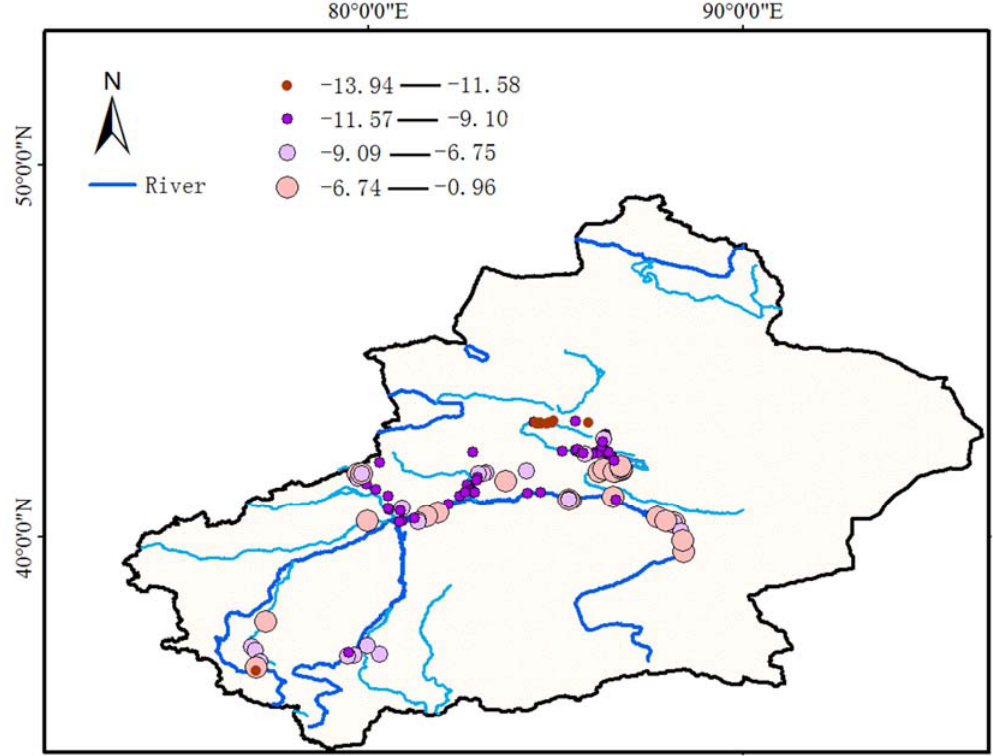
Figure 5. The spatial variations of river water δ 18 O in Hotan River, Yarkand River, Aksu River and Kaidu River (Tarim River Basin) according to mass balance. Large variation of climatic conditions and human activities.